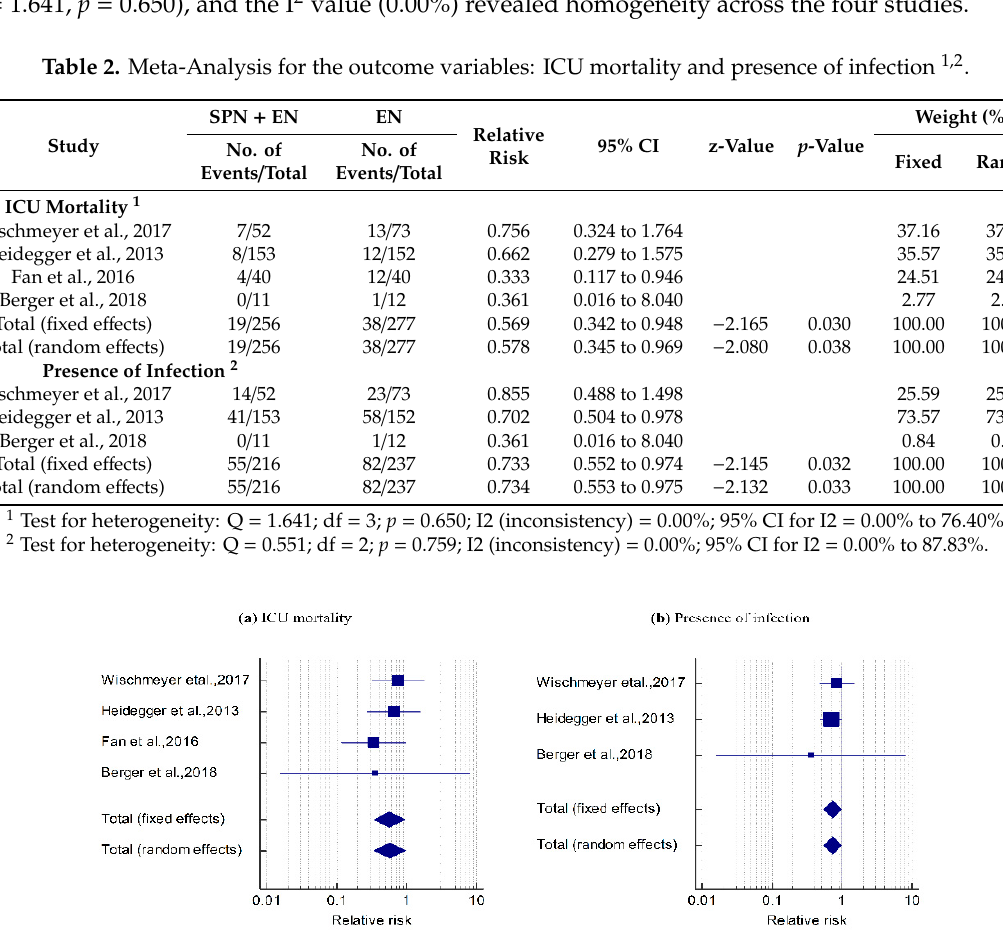
Figure 2. Forest plot showing the effect of the SPN + EN on ( a ) ICU mortality: pooled RR = 0.569, z = − 2.165, p = 0.030. The Cohran’s Q was not statistically significant (Q = 1.641, p = 0.650) and I 2 = 0.00%. ( b ) The presence of infection events: pooled RR = 0.733, z = − 2.145, p = 0.032. Q = 0.551, p = 0.759 and I 2 value = 0.00%. Table 2. Meta-Analysis for the outcome variables: ICU mortality and presence of infection 1,2 .